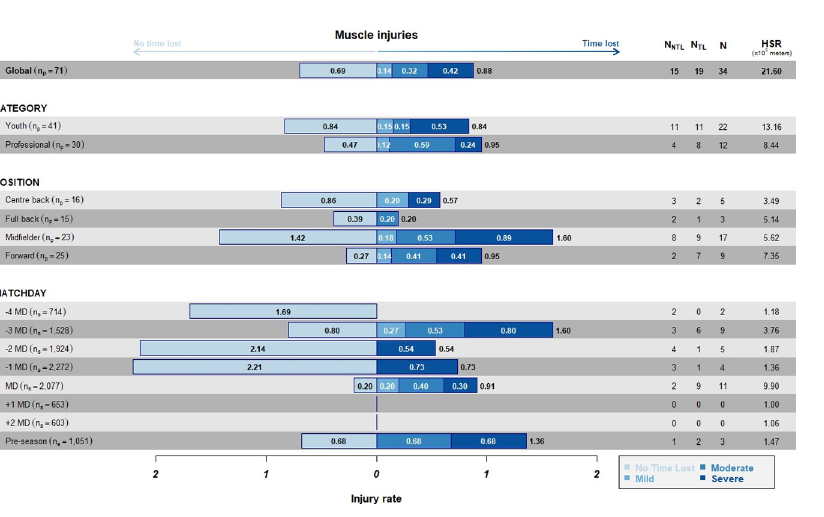
Fig 5. Incidence of TL and NTL injuries per 10 5 m of high-speed running stratified by category, position, and days to/from the match. Numbers inside bars represents the incidence according to the severity.